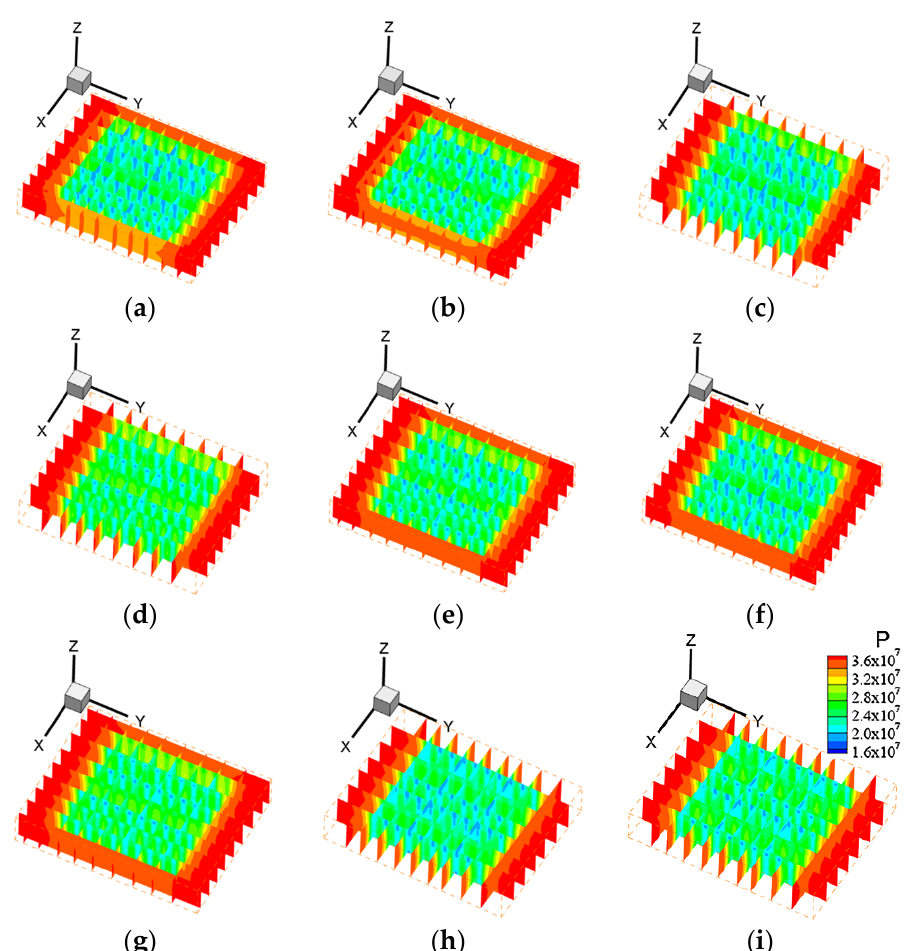
Figure 16. Vertical well pressure distribution field diagram after different development schemes. ( a ) scheme 1; ( b ) scheme 2; ( c ) scheme 3; ( d ) scheme 4; ( e ) scheme 5; ( f ) scheme 6; ( g ) scheme 7; ( h ) scheme 8; ( i ) scheme 9.